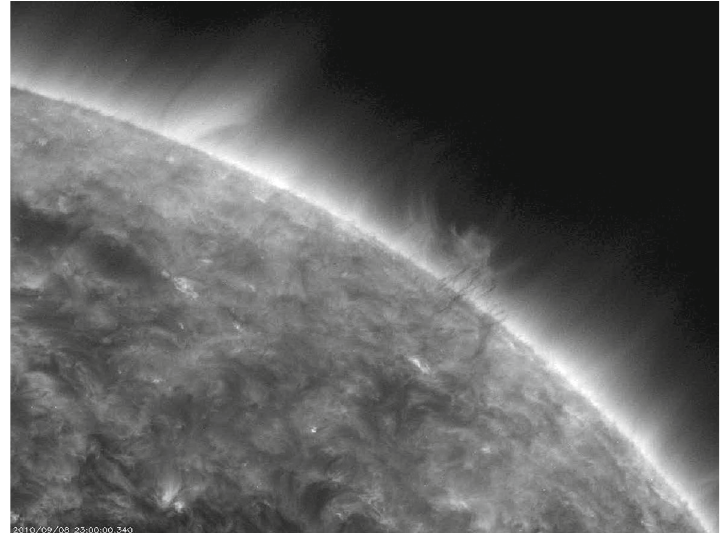
Fig. 3 Still from a movie showing a limb prominence whose global transverse oscillations were analysed by Gosain and Foullon (2012). (To watch the movie, please go to the online version of this review article at